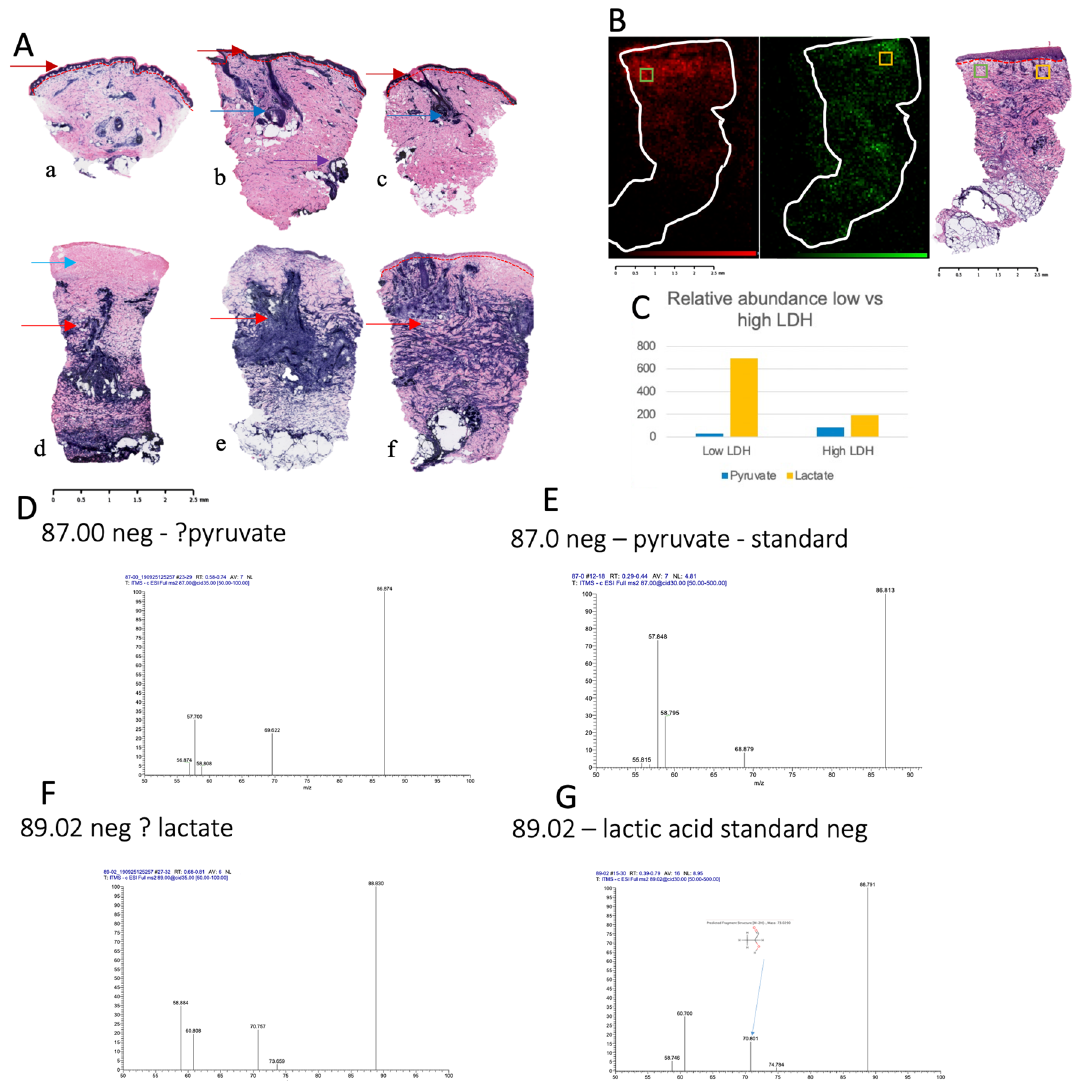
Figure 1. Examples of LDH stain pattern are shown in ( A ). All images at 50X magnification with 2.5 mm scale bar: (a–c) typical appearance of control skin with heavy LDH staining epidermis (dark red arrows), hair follicles (dark blue arrows), and sweat glands (purple arrow); (d–f—burn skin sections) (d) burn skin section with “classic” LDH staining—note complete absence of LDH in superficial part of tissue(light blue arrow); (e–g) burn skin sections showing non-linear LDH pattern of distribution in papillary and reticular dermis (red arrows). Red dotted line indicates epidermo-dermal junction when seen. Note epidermal cells not visualised in (e) or (g). ( B ) Left image (red): Desorption Electrospray Ionisation mass spectrometry image (DESI MSI) of m/z 89.0246 (lactic acid) for burn sample. Middle image (green): DESI MSI of m/z 87.0085 (pyruvate in same sample. Right image: LDH stain from same sample at 50 × magnification. Red dotted line indicates epidermo-dermal junction. Note the relative increase of lactate (in red) in the upper left region of the tissue corresponding with relatively less LDH stain update. White outline on mass spectrometry images indicates outline of tissue area. Scale bar shown. Note the spatial corelation between LDH staining and pyruvate and the anti-colocalization to lactate. Control skin shown in supplementary information. ( C ) Relative abundance for low LDH (green box In B ) vs high LDH (yellow box in B ) of lactic acid (m/z 89.026) and pyruvate (m/z 87.0085) in negative ion mode. ( D-G ) Fragmentation pattern of ? Pyruvate (m/z 87.00) ( D ) and ? Lactate (m/z 89.02) ( F ) compared against fragmentation pattern of commercially purchased pyruvate standard (m/z 87.0) ( E ) and lactic acid (m/z 89.02) ( G ) in negative ion mode. Note the similar fragmentation patterns, indicating identical molecular